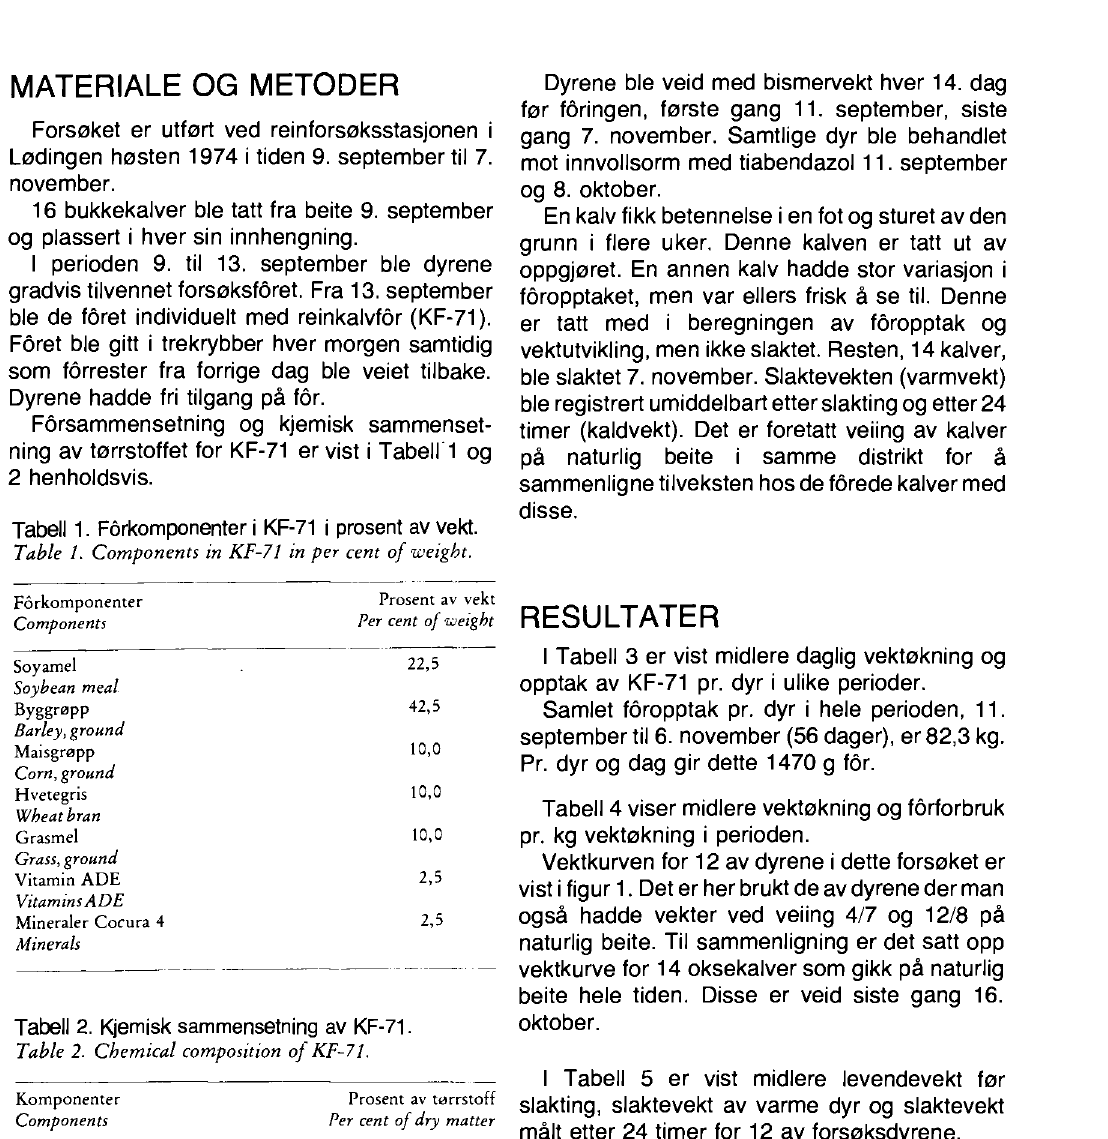
Table 2. Chemical composition of